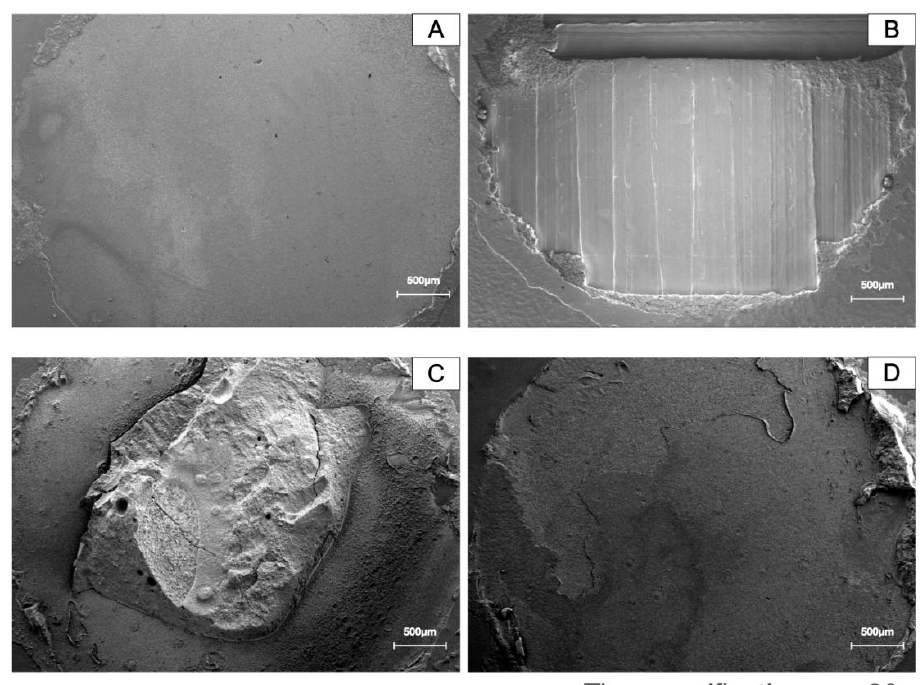
Figure 7. The representative failure modes of the bonding between PEEK and the veneering resin. ( A ) Adhesive failure between PEEK and resin materials, ( B ) cohesive failure within PEEK, ( C ) cohe- sive failure within resin materials, and ( D ) mixed failure with both cohesive and adhesive fail- ures.